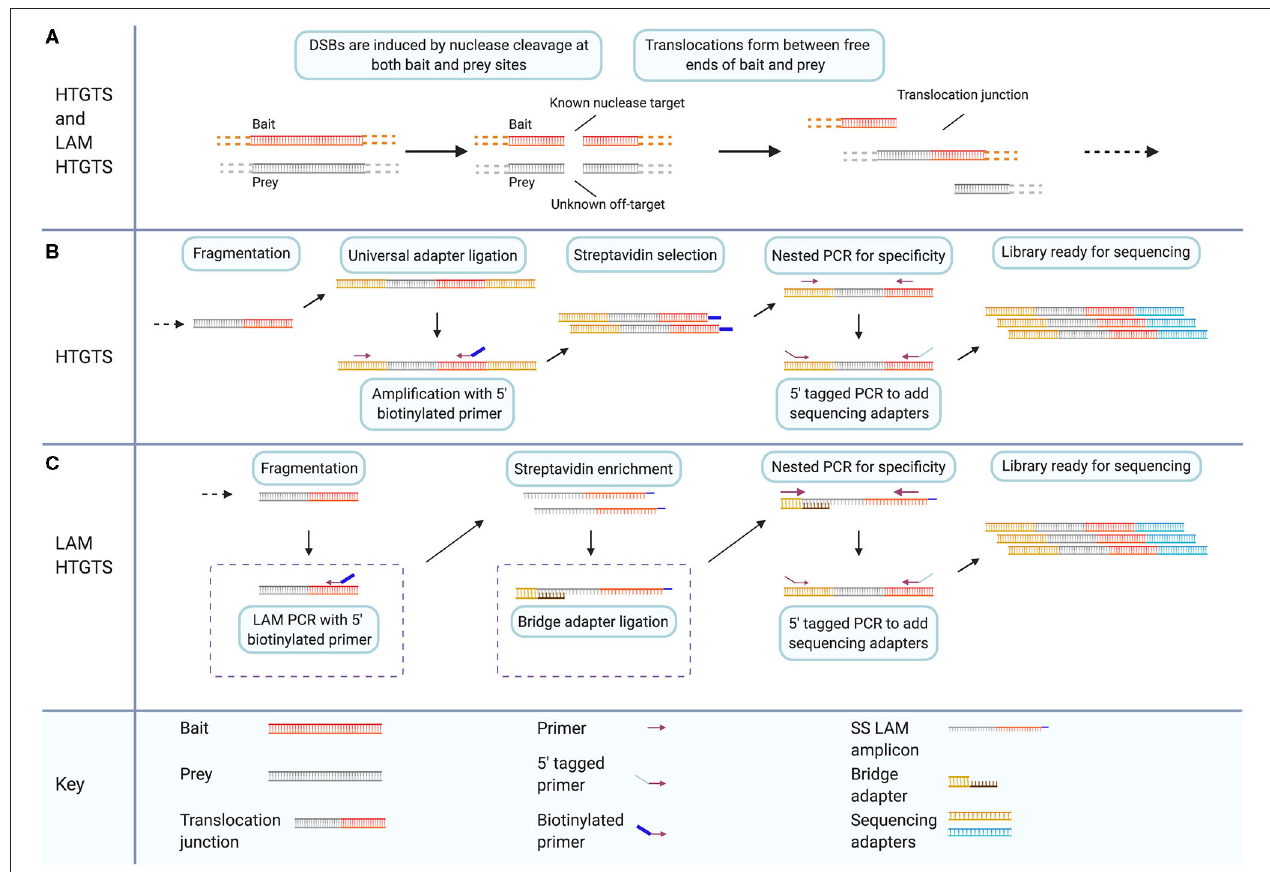
FIGURE 4 | LAM HTGTS has two specific modifications that enhance target enrichment compared to the original method and enable sensitive detection of off-target nuclease cleavage. (A) Both HTGTS and LAM HTGTS begin by inducing DSBs through nuclease cleavage in cells for known and unknown sequence targets